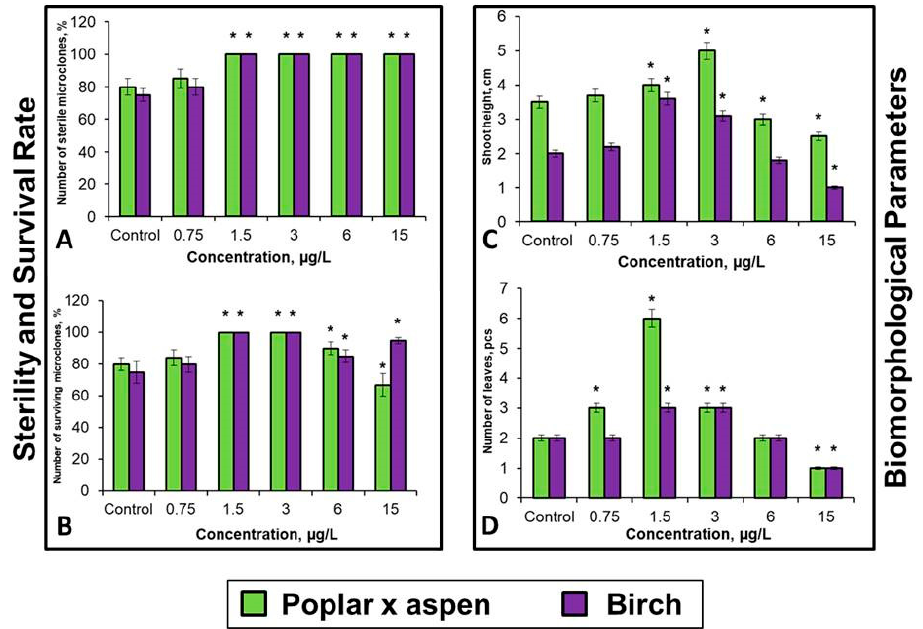
Figure 2. Biomorphological parameters of the microclones at the initiation stage: ( A ) Mean number of sterile microclones; ( B ) Mean number of survival microclones; ( C ) Mean shoot height; ( D ) Mean number of leaves (hereinafter the height of the column corresponds to the mean value, bar—to the standard deviation, * is significant deviation from control).